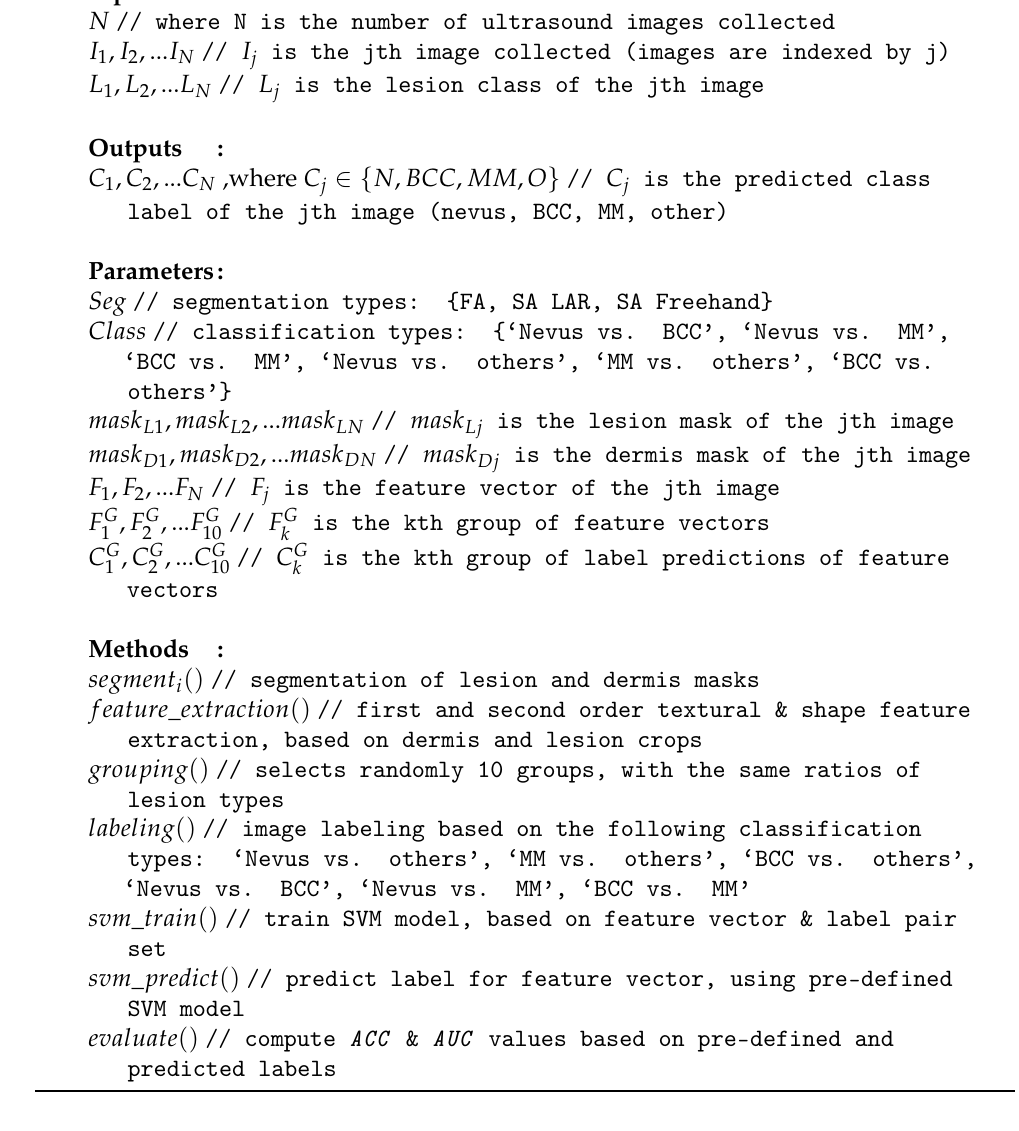
Algorithm 1: Skin lesion classification algorithm—Part I. Variables and Methods.